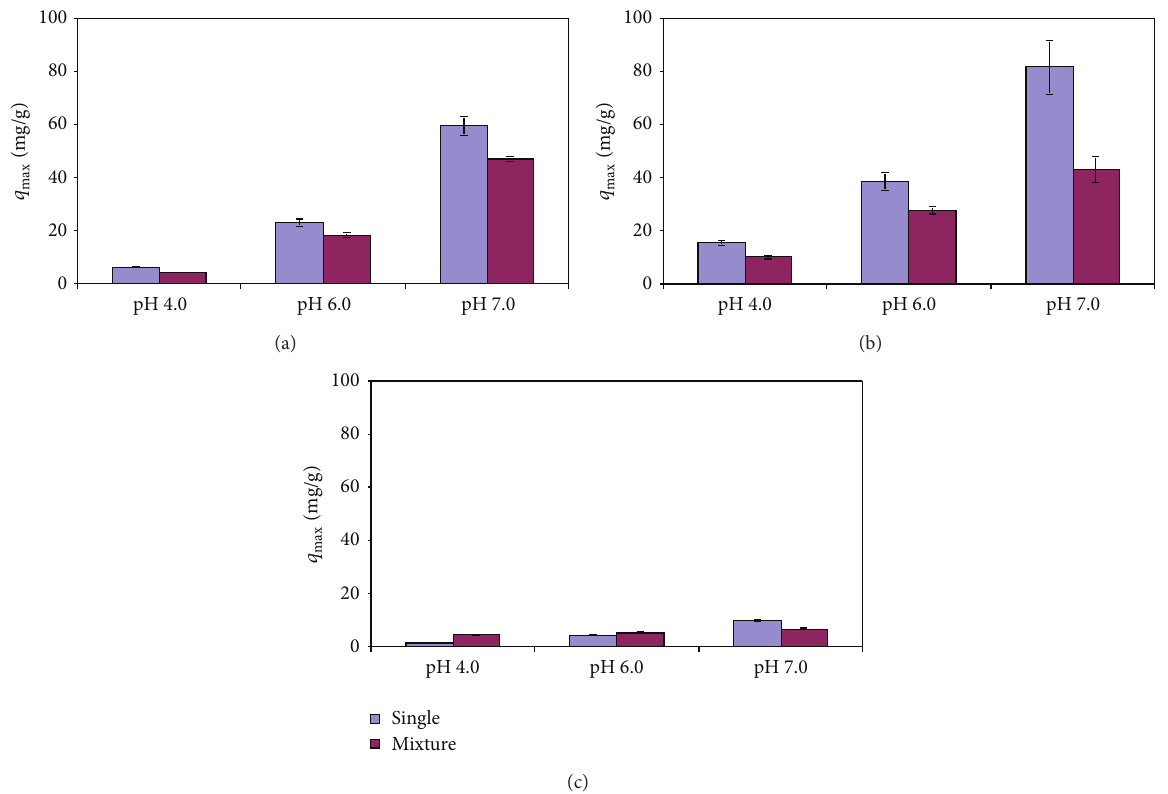
Figure 5: Comparison of the maximum adsorption capacities of Cu(II), Pb(II), and Cd(II) on magnetic GO between the single- and multimetal adsorption at pH 4.0 (a), 6.0 (b), and 7.0